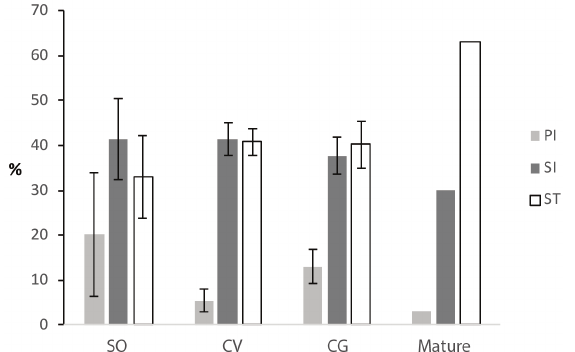
Figure 4 - Classification of the percentage of species by dispersal syndromes (abiotic and zoocoric) in the burnt forest fragments Sooretama (SO, 14-yrs after fire), Córrego do Veado (CV, 25-yrs after fire) and Córrego Grande (CG, 25-yrs after fire) and an adjacent mature forest (Paula and Soares 2011), ES, Brazil.